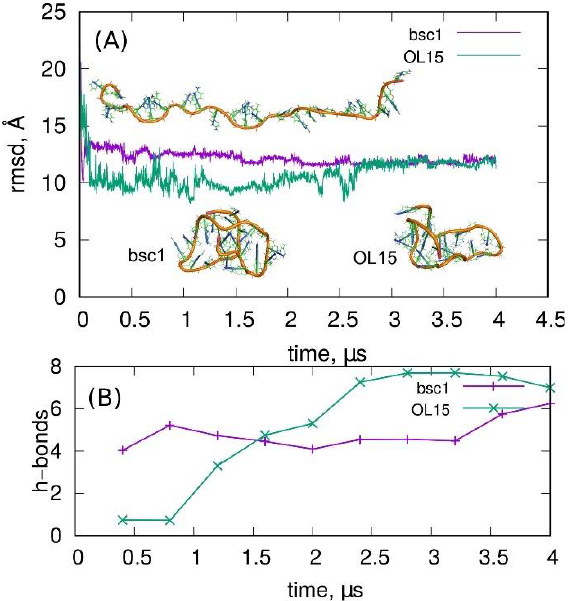
Figure 3. Root-mean-square displacement (rmsd) from the ideal i-motif structure for a C-rich se- quence containing C:C + pairs, i.e., ready to form the structured i-motif. The computations were carried out using two parameterizations of the Amber force field, i.e., bsc1 and OL15. The snapshot in the upper part of ( A ) shows the initial sequence in the random coil state, while the snapshots at the bottom are the final structures obtained after 4 μs simulation times. ( B ) The number of hydrogen bonds between C:C + pairs during the simulation.